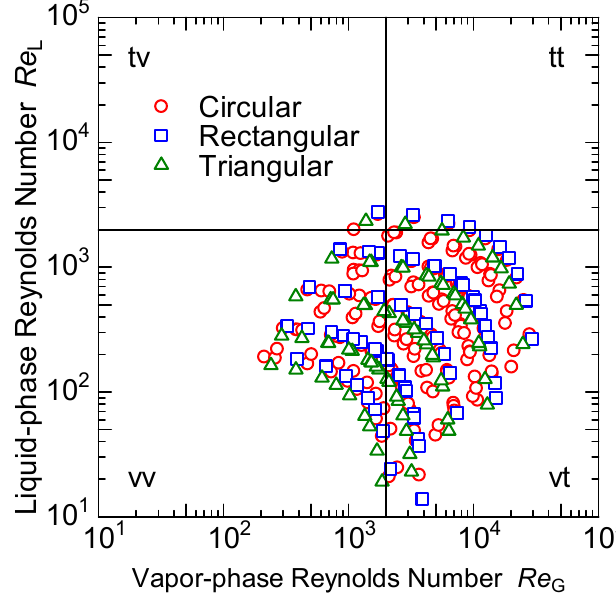
Figure 4. Distribution of all data in plot of Re L vs. Re G.